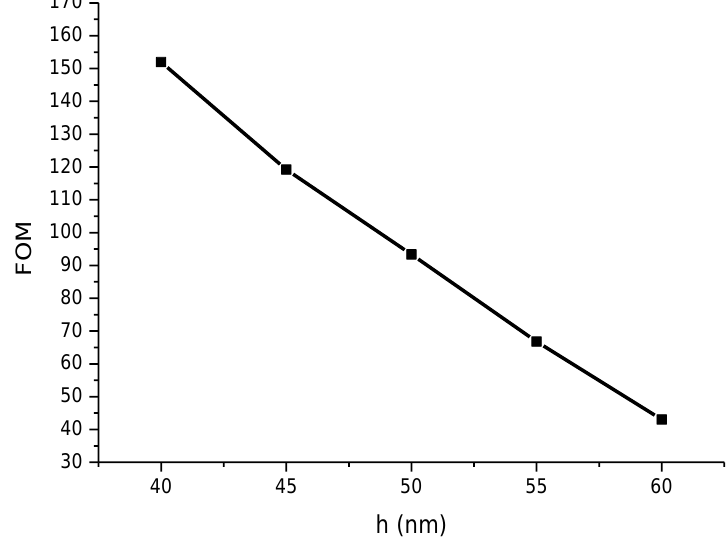
207 Figure 6. ( a ) Transmission spectrum of different coupling distances d ; ( b ) transmission spectrum of 208 different heights of rectangular stubs h .